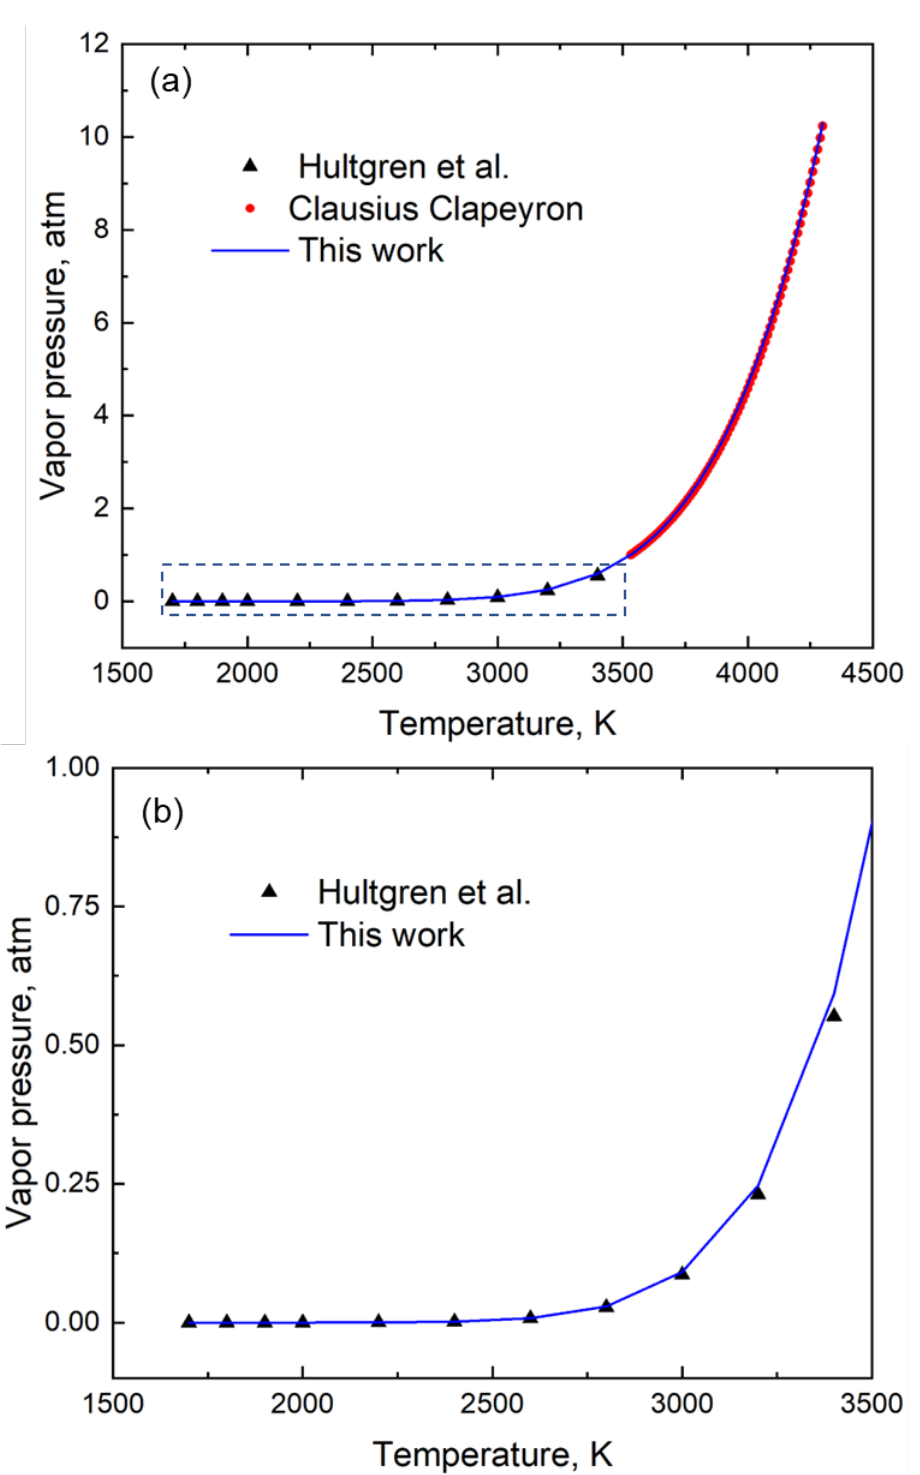
Figure 2. ( a ) A plot of vapor pressure with temperature for Silicon (Si). The coefficients A = 17,250, B = − 15.97, C = 6.403 and D = − 0.5281 shown in Table 2 are used in Equation (2) to generate the blue curve in this plot. The region marked by the rectangle is shown separately in 2(b). ( b ) Enlarged section of the vapor pressure data between 1500 K and 3500 K shows a good fit with the equation. The experimental data from Hultgren et al. [12] and the fitting results between 1700 K and 3400 K are tabulated in the Appendix A.